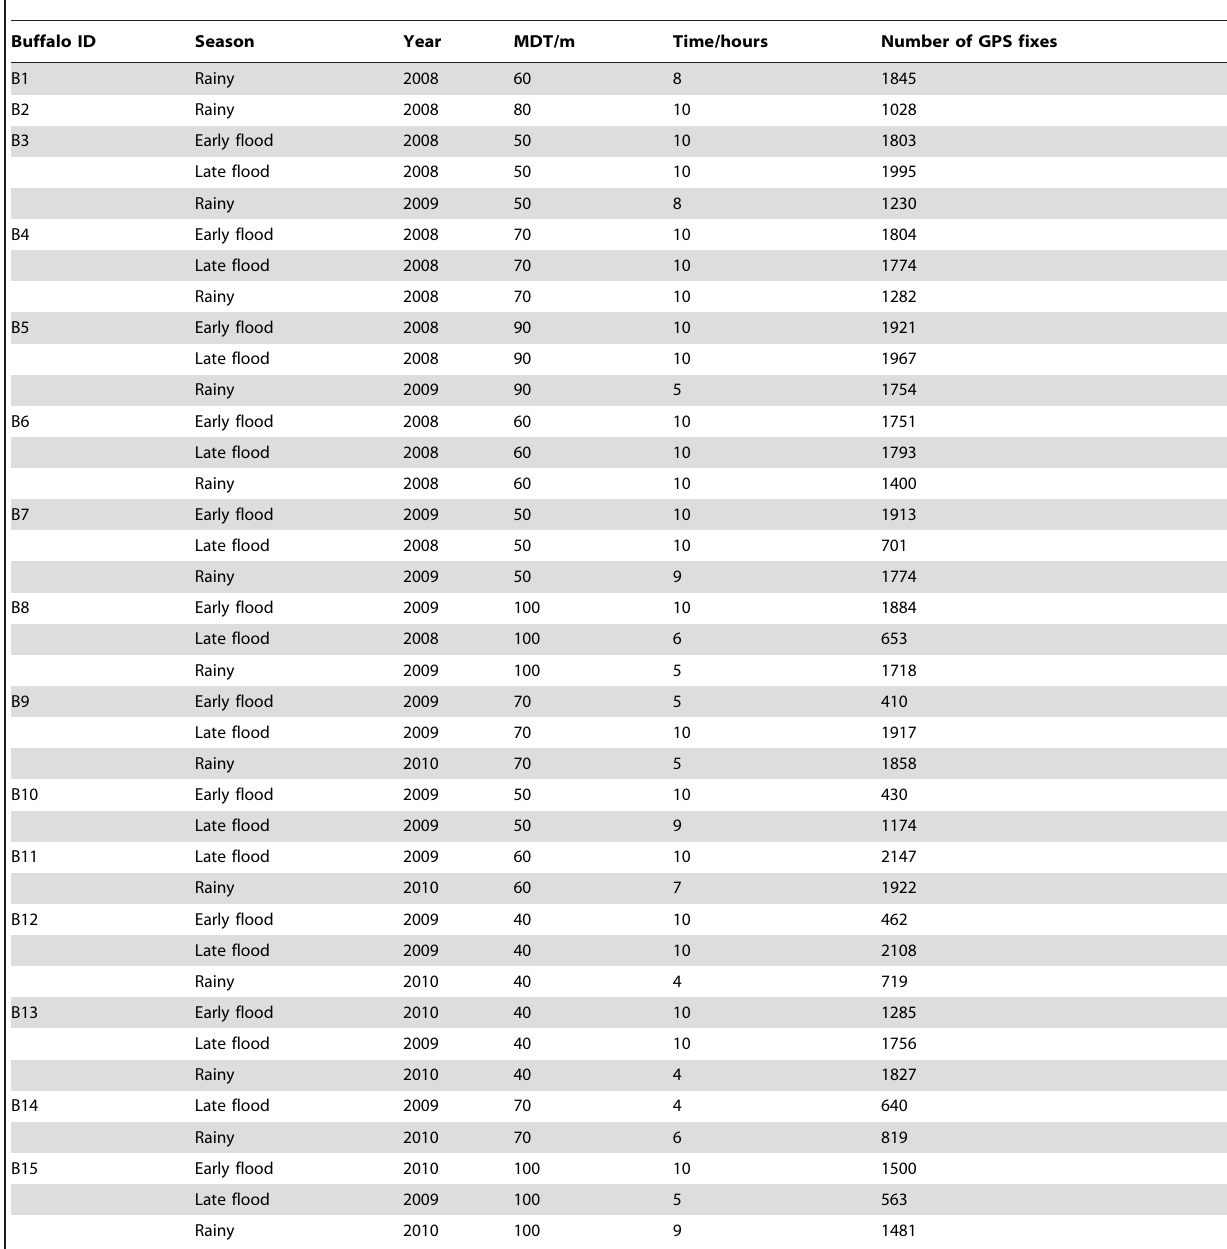
Table 3. Number of GPS fixes and the parameters used to calculate the utilisation distributions each season for the 15 buffalo